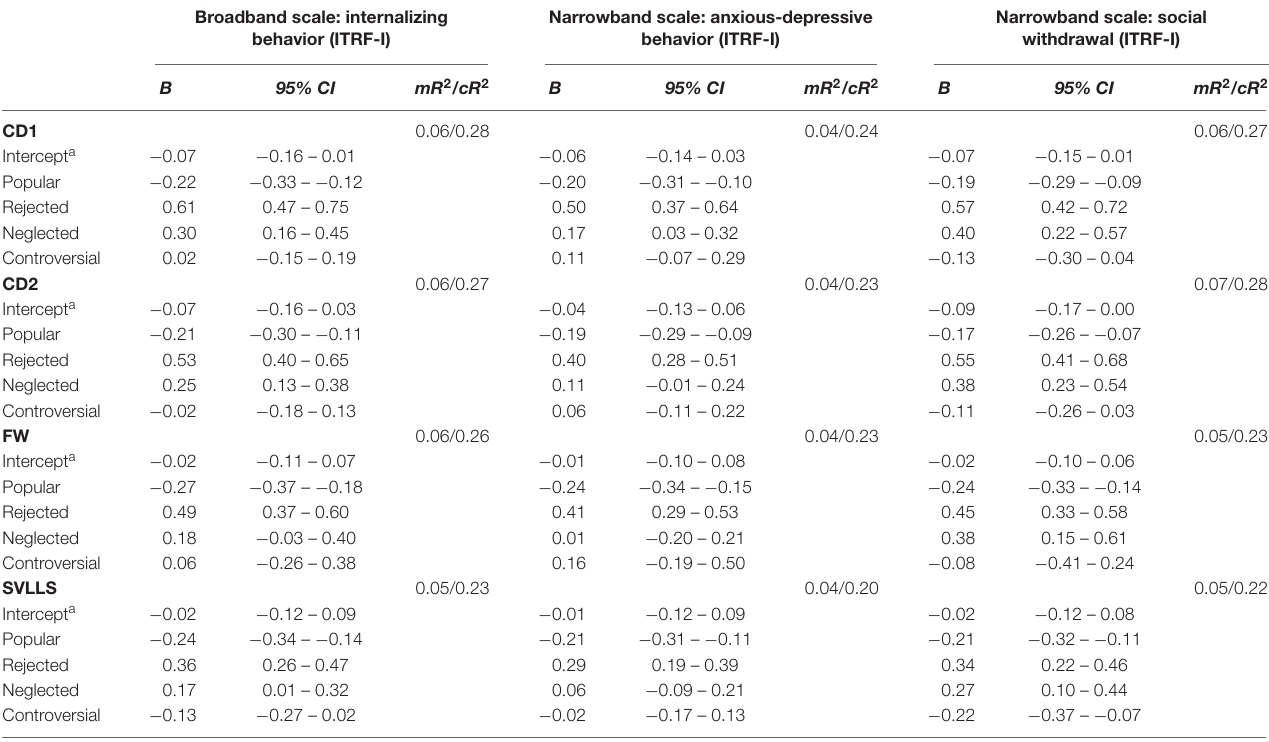
TABLE 3 | Internalizing behavior (broadband and narrowband scales) regressed on sociometric status. Broadband scale: internalizing Narrowband scale: anxious-depressive Narrowband scale: social behavior (ITRF-I) behavior (ITRF-I) withdrawal